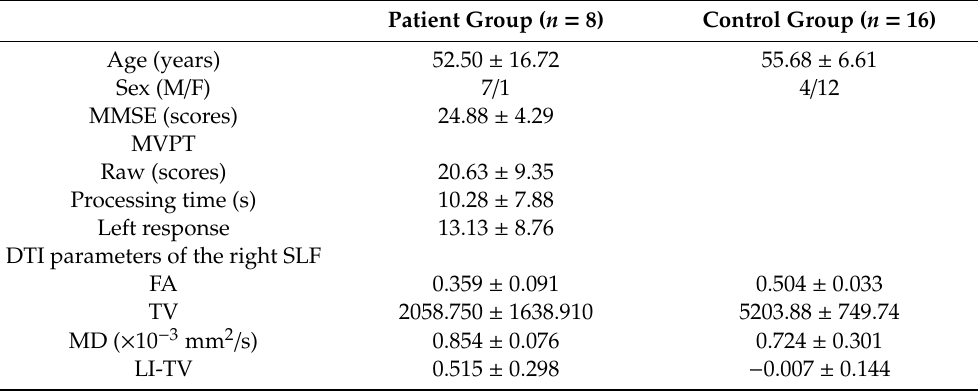
Figure 1. T2-weighted brain magnetic resonance images of all of the patients with stokes in the right hemisphere within four or five weeks after onset. In patients 1, 2, 4, 5, and 6, intracranial hemorrhage (ICH) in the right hemisphere is visible. Patients 3, 7, and 8 have a cerebral infarction in the right hemisphere. Patient 1: ICH in the right thalamus and posterior limb of the internal capsule. Patient 2: ICH in the right parietal lobe. Patient 3: cerebral infarction in the right frontal lobe, insular cortex, and basal ganglia. Patient 4: ICH in the right thalamus, posterior basal ganglia, and parietal lobe. Patient 5: ICH in the right basal ganglia. Patient 6: ICH in the right basal ganglia, right thalamus, right insula, and right front-parietal lobe. Patient 7: cerebral infarction in the right frontal lobe, insular cortex, and parietal lobe. Patient 8: cerebral infarction in the right basal ganglia and frontotemporal lobe. Note: ICH, intracranial hemorrhage; R, right; A, anterior. “R” and “A” in patient 1 are reflected throughout the patient’s image. Table 1. Parameters obtained for the present